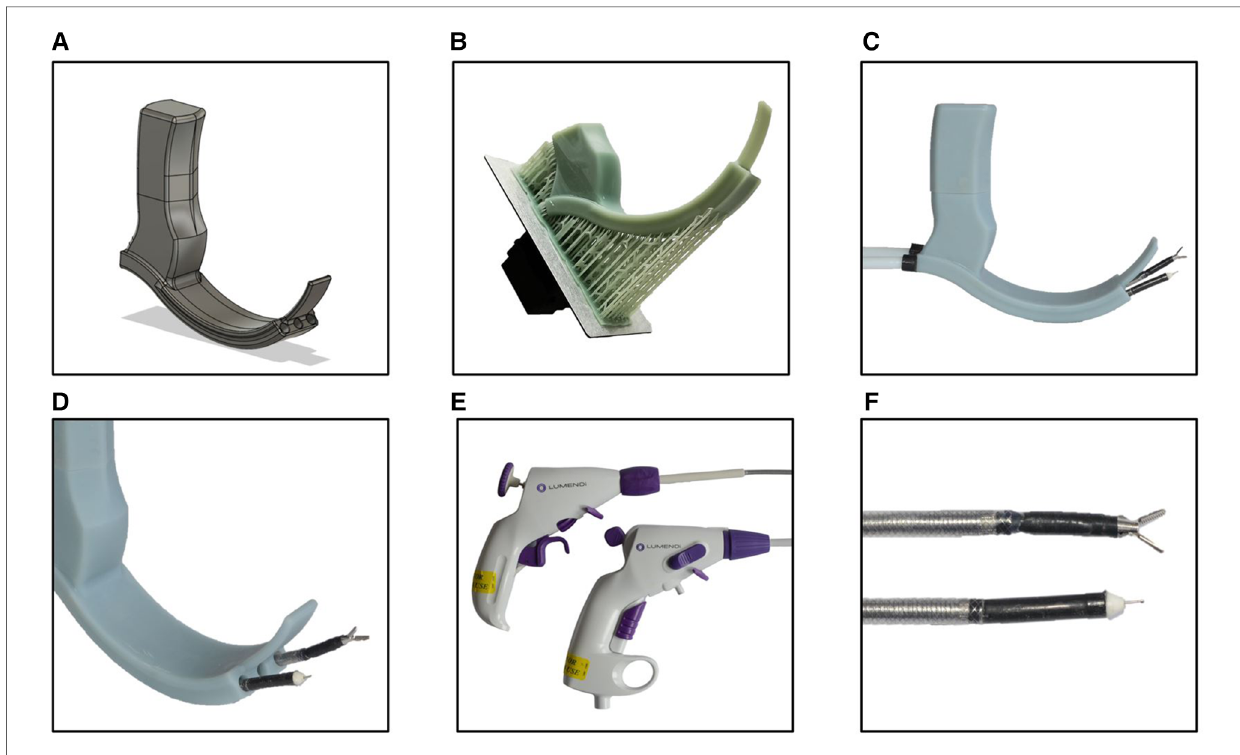
FIGURE 1 ( A ) CAD model of the sMAC laryngoscope with integrated working channels. ( B ) 3D-printed blade of the laryngoscope with support structures still attached. ( C,D ) Assembled 3D-printed sMAC laryngoscope with fl exible instruments introduced to the working channels. ( E,F ) Control units and instrument tips of the fully fl exible surgical